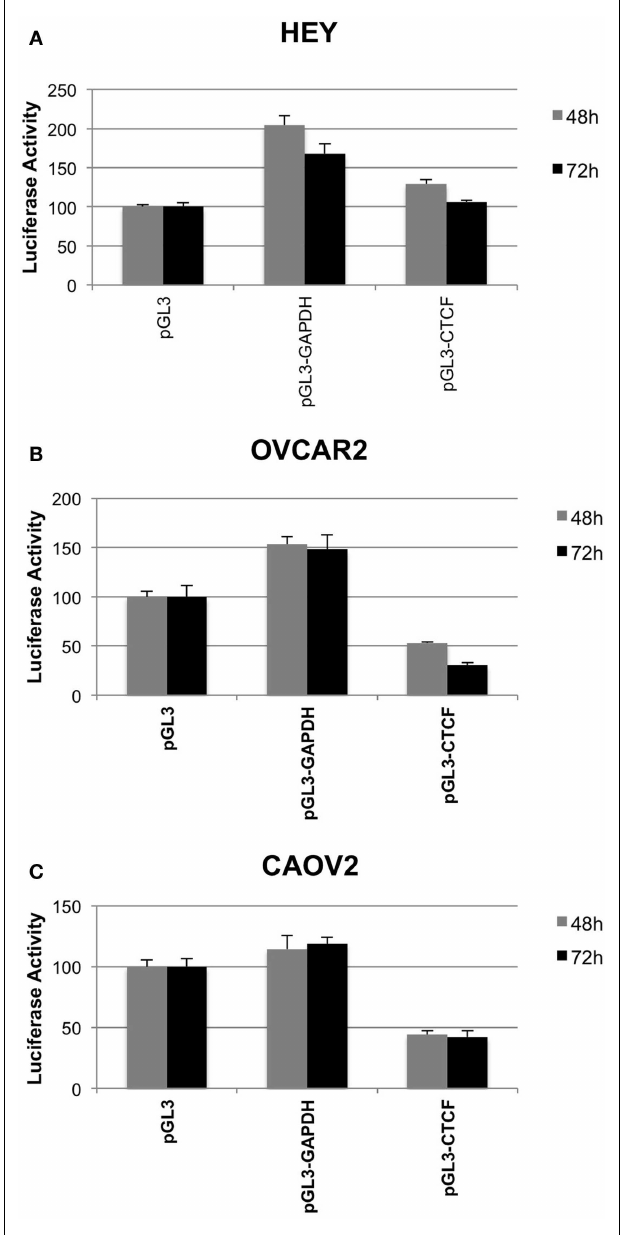
FIGURE 6 | Insulator activity of the IGF2 intron 3 CTCF binding motif in ovarian cancer cells . Luciferase activity from various pGL3 plasmid constructs, as a read out for the capacity of the IGF2 intron 3 sequence motif to inhibit interactions between the enhancer and promoter of the plasmid, is shown on the y axis ( + SD) in each panel. HEY cells (A) , OVCAR2 cells (B) and CAOV2 cells (C) were analyzed in sextuplicate at 48h (light gray) and 72h (dark gray) post-plasmid transfection. pGL3, control plasmid with no insert; pGL3-GAPDH, plasmid with sequence fragment of the GAPDH locus that does not contain a consensus CTCF binding motif; pGL3-CTCF, plasmid with the IGF2 intron 3 CTCF binding